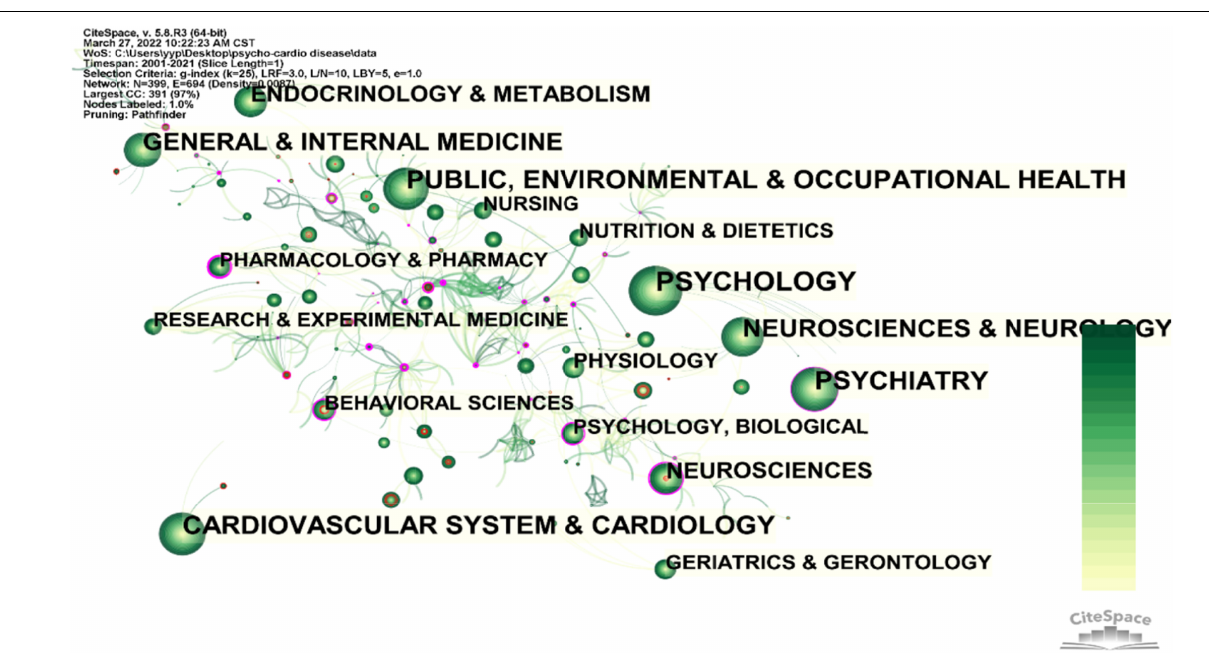
depression, anxiety, and posttraumatic stress disorder (48).